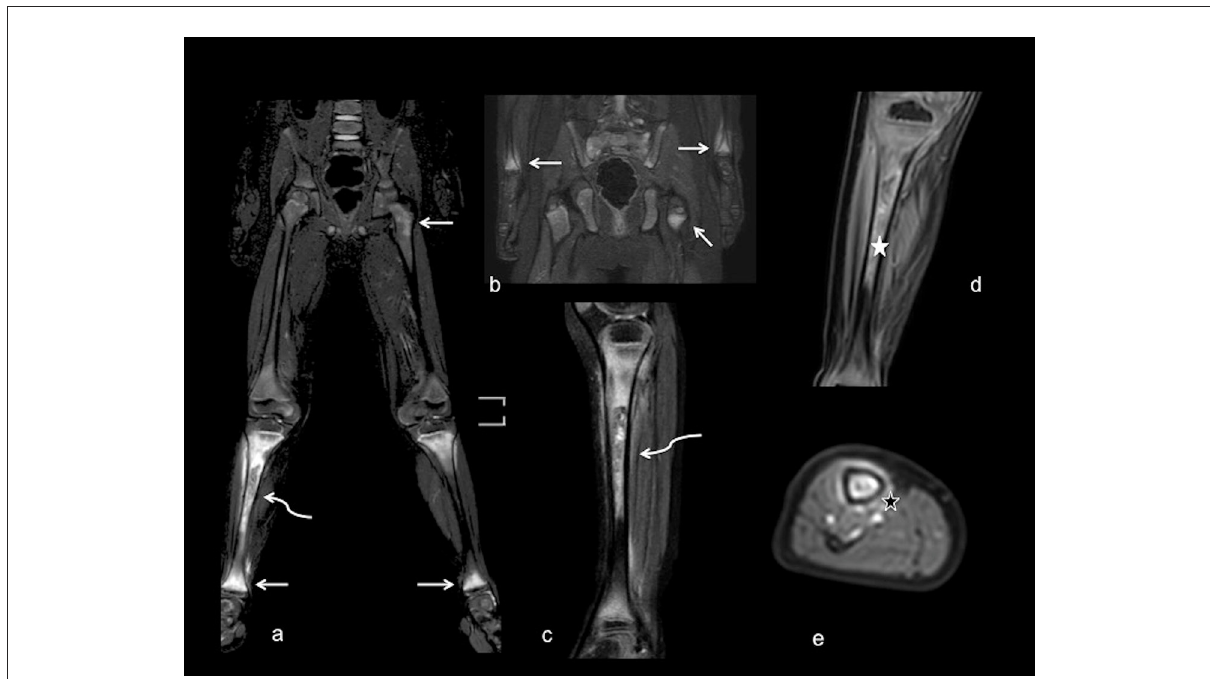
FIGURE2 MRI with large field of view. Coronal (a,b) and sagittal (c) T2-weighted fat saturated views demonstrate abnormal marrow signal of femoral, tibia and wrist metaphyses (white arrows) bilaterally, with more evident involvement of right tibia diaphysis, showing abnormal inhomogeneous signal intensity (curved arrows). Coronal and axial views (d,e) after contrast administration show inhomogeneous enhancement of bone marrow (white star) and periosteal tissue (black star), without periosteal